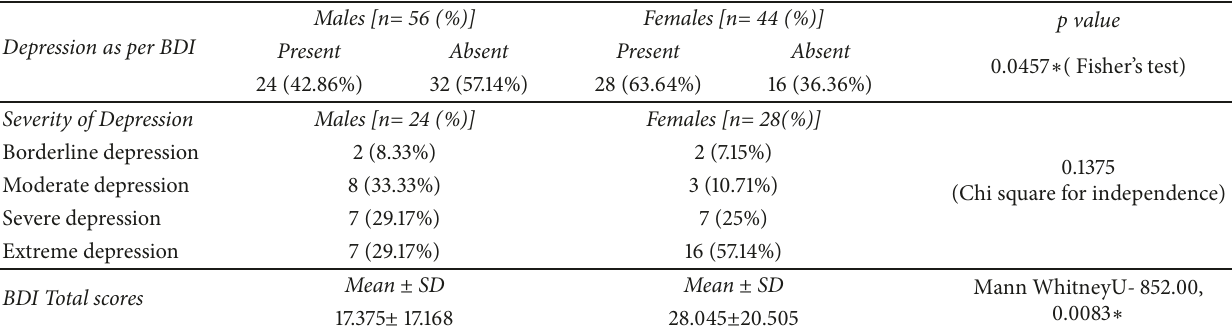
Table 2: Prevalence and severity of depression as per